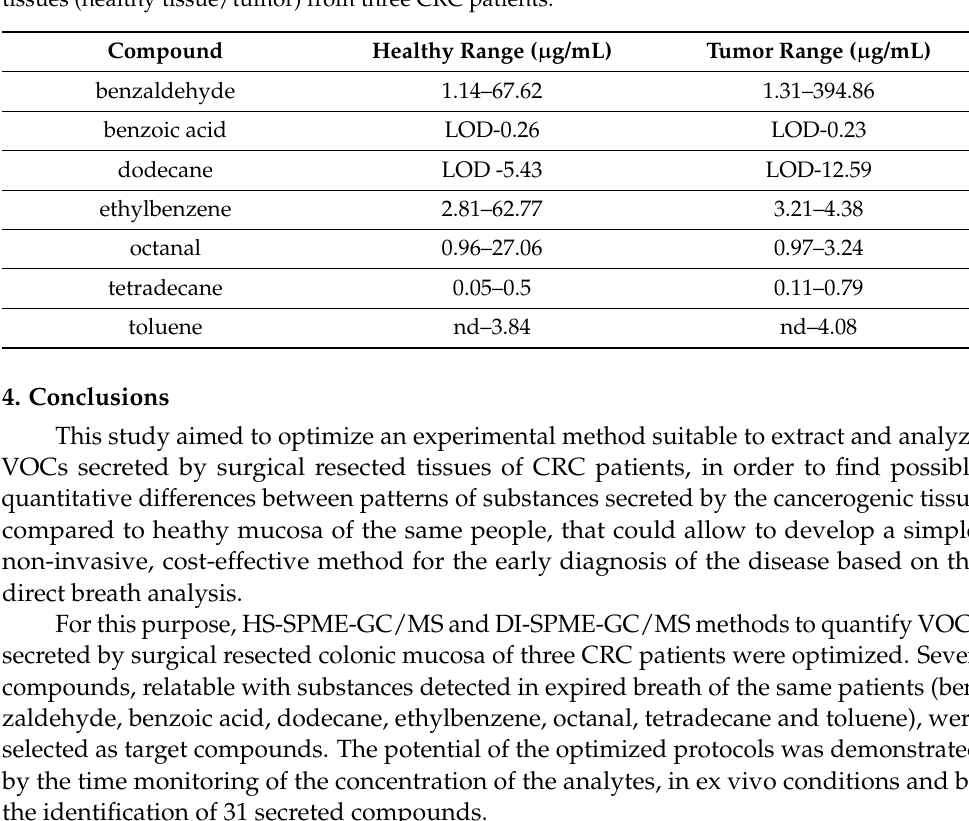
Table 4. Concentration ranges of the target compounds estimated in the surgical resected colon tissues (healthy tissue/tumor) from three CRC